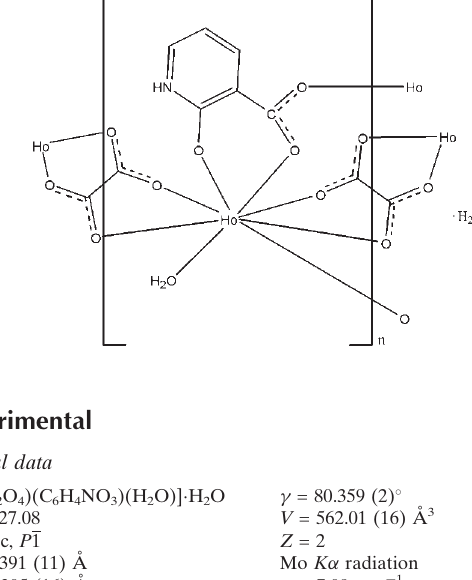
Bruker APEXII CCD diffractometer